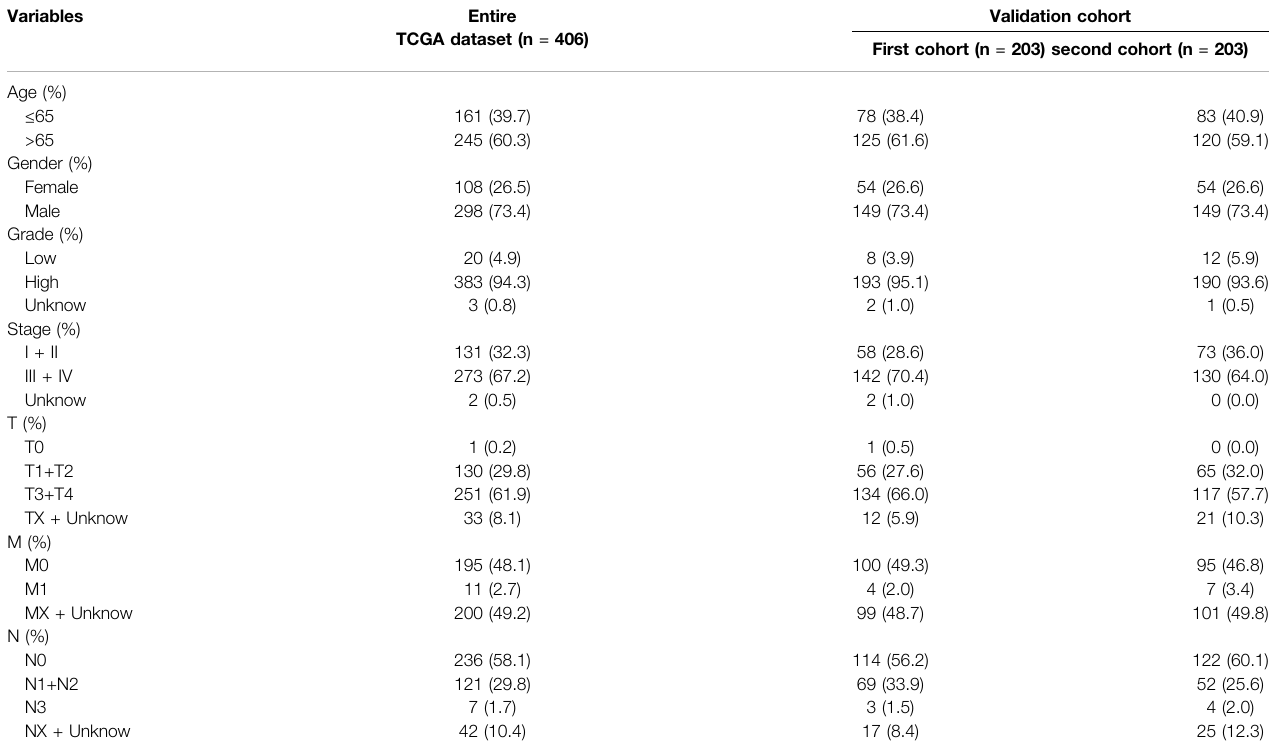
TABLE 1 | The clinical characteristics of patients in different cohorts.